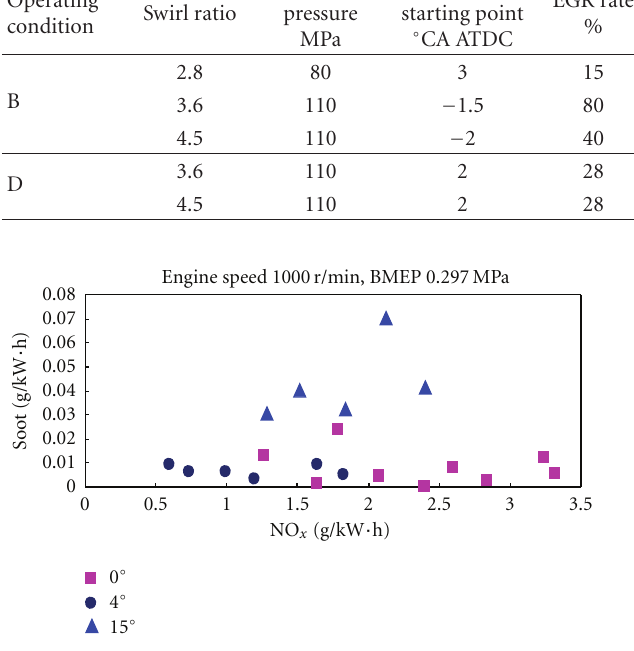
Figure 10: E ff ect of the impingement angle on NO x and soot